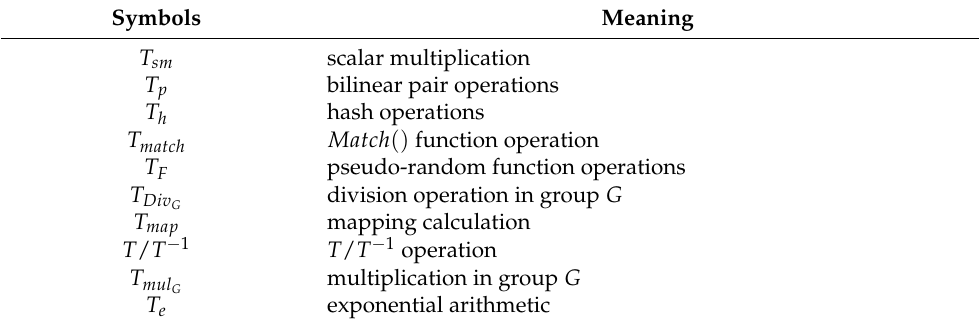
Table 2. Computation